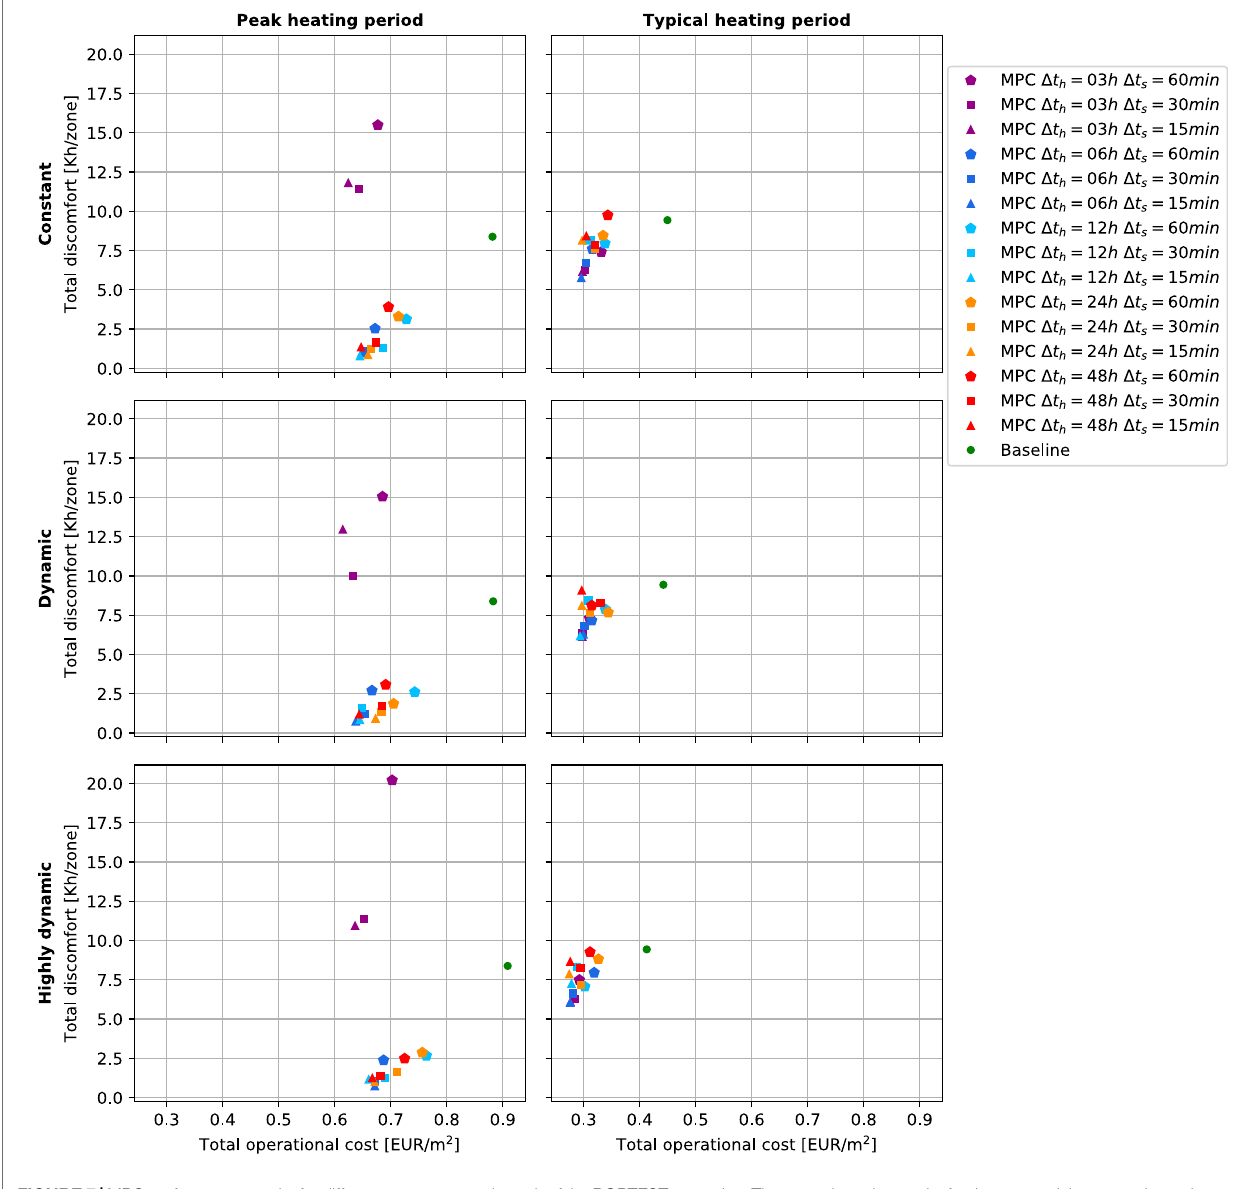
Frontiers in Built Environment |